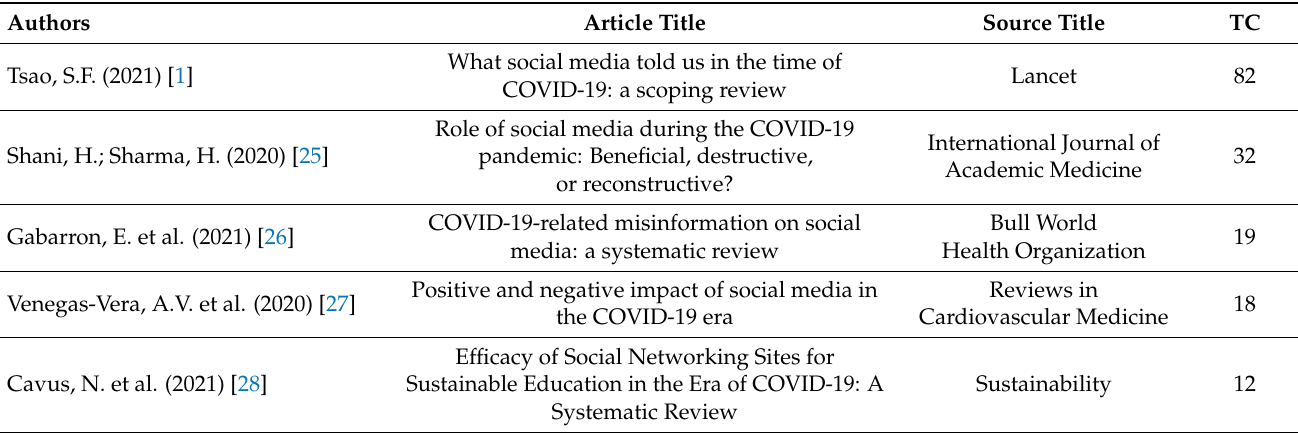
Table 8. Top 5 review articles by total